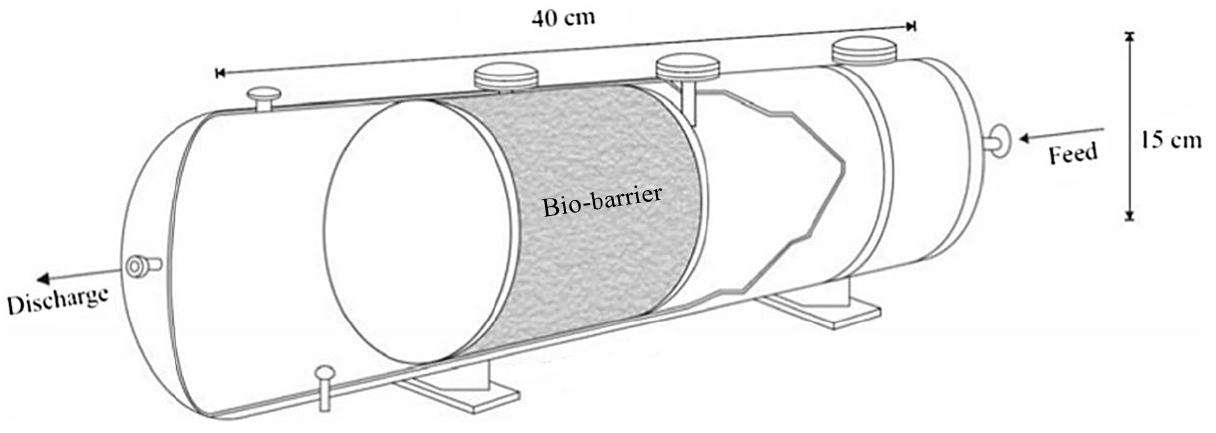
Figure 1. Permeable bio-barrier reactor design.